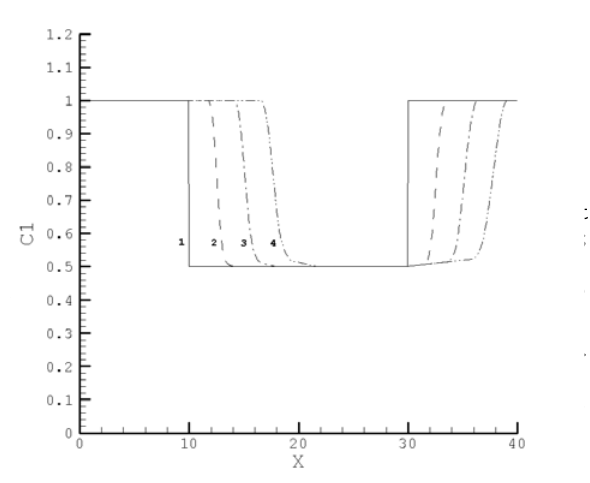
Fig. 4. The concentrational traveling wave solution of (7) with the initial distribution from (21)-(22); flow velocity u=0.25 .